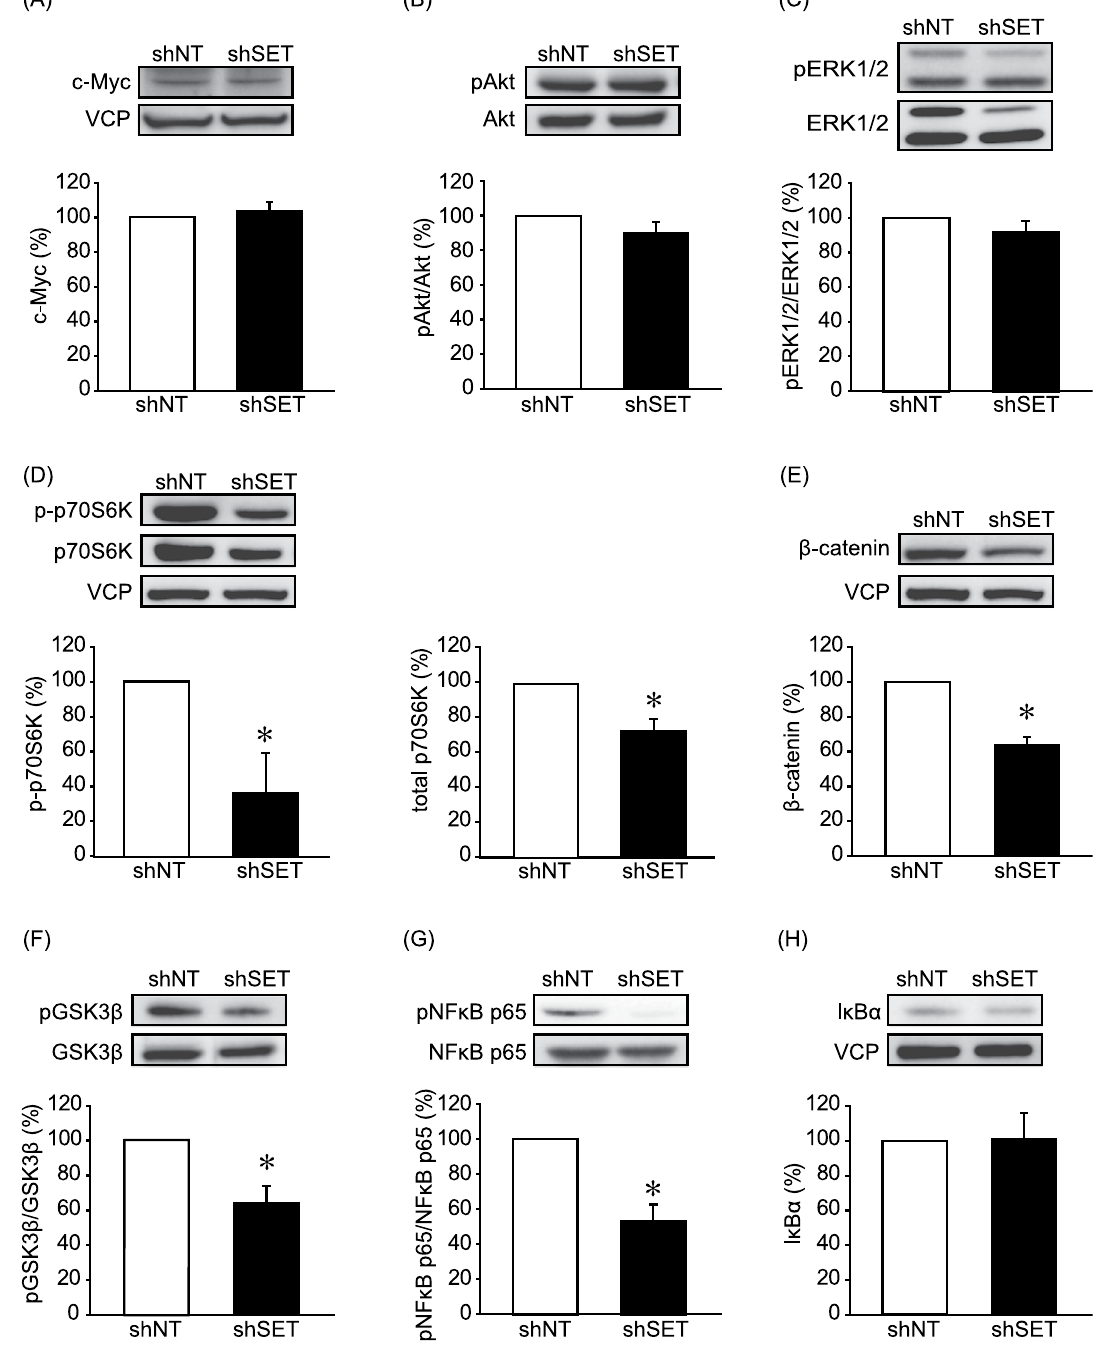
Figure 4. SET knockdown suppressed mTORC1/p70S6K, β -catenin, and NF κ B signaling. Levels of phosphorylation/protein of c-Myc ( A ), ERK1/2 ( B ), Akt ( C ), p70S6K ( D ), β -catenin ( E ), GSK3 β ( F ), NF κ B p65 ( G ), and I κ B α ( H ) of CIP-m cells were determined by immunoblotting. Quantitative data from 3–6 independent experiments are shown. * P < 0.05 vs.